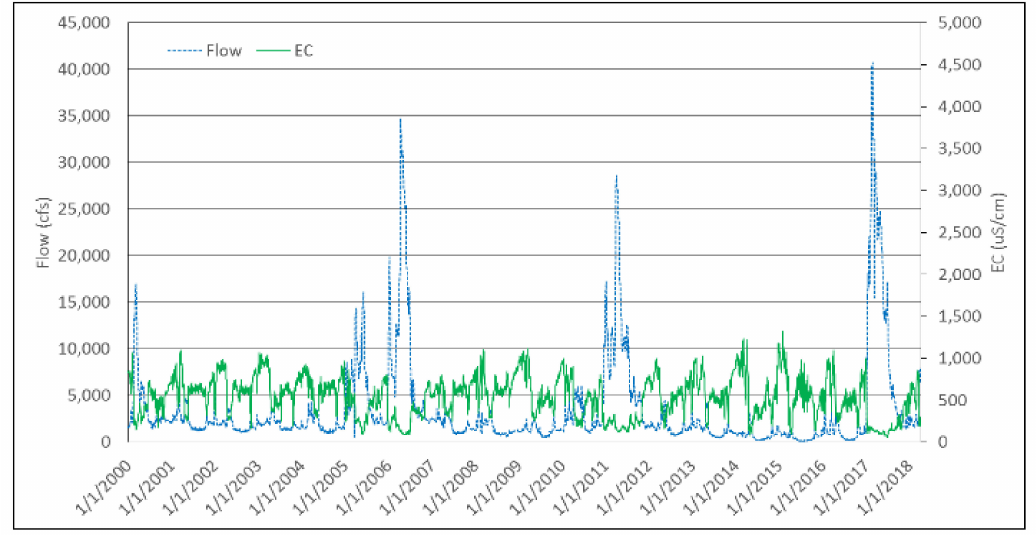
Figure 4. Flow and EC observations at Vernalis compliance monitoring station on the SJR for the period